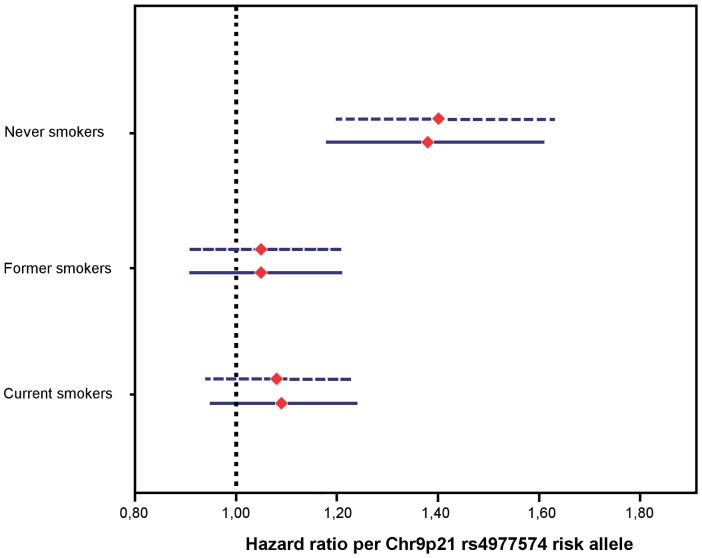
CVD-mortality by rs4977574 stratified by smoking status.Hazard ratios (HR) with 95% Confidence Interval per risk allele of rs4977574 in never (N = 9642) former (N = 8297) and current (N = 7000) smokers respectively. Models adjusted for age and sex (dotted upper lines) and adjusted for covariates age, sex, smoking status, education, physical activity, systolic blood pressure, antihypertensive medication and BMI (continuous lower lines).